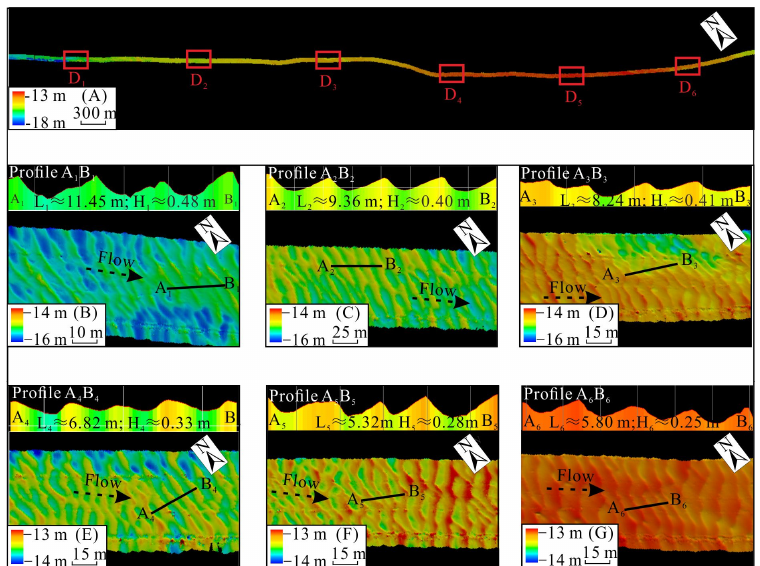
Figure 6. Diagram of the dune in the SC of the Yangtze River Estuary. ( A ) is the distribution diagram of the dune in SC with an inverse bed slope. D1–D6 represents the location of the dune group (Figure 1C). ( B – G ) are images of the morphology of the dune.